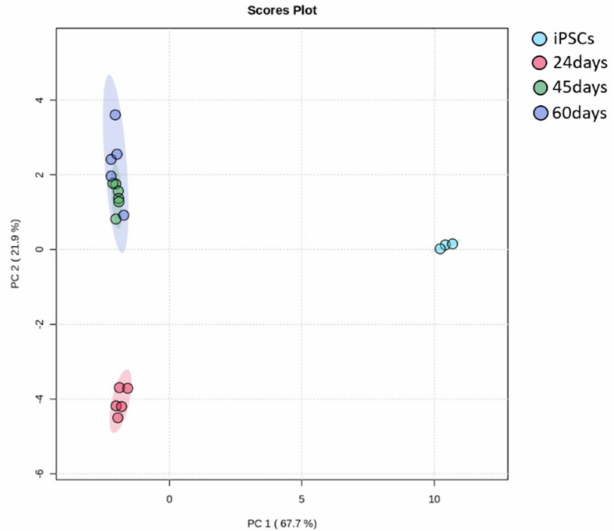
Figure 6. Principal component analysis (PCA) from metabolomics of iPSCs and dopaminergic neurons at days 24, 45 and 60 of differentiation.